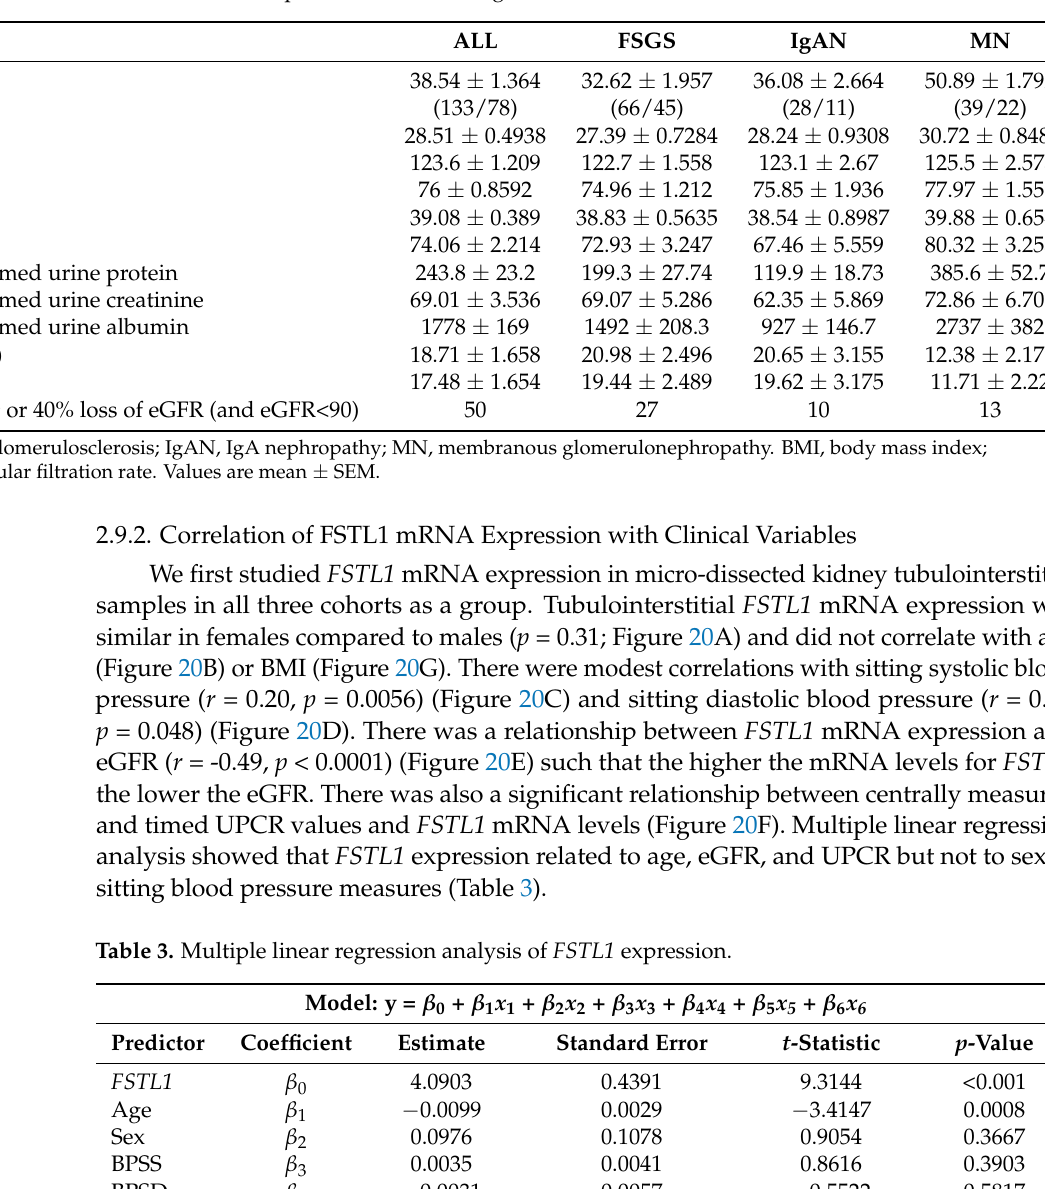
Table 2. Demographic and clinical characteristics of patients with FSGS, IgAN, and MN.